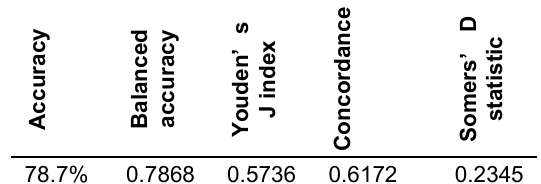
Table 7. Comparing evaluation metrics of algorithms